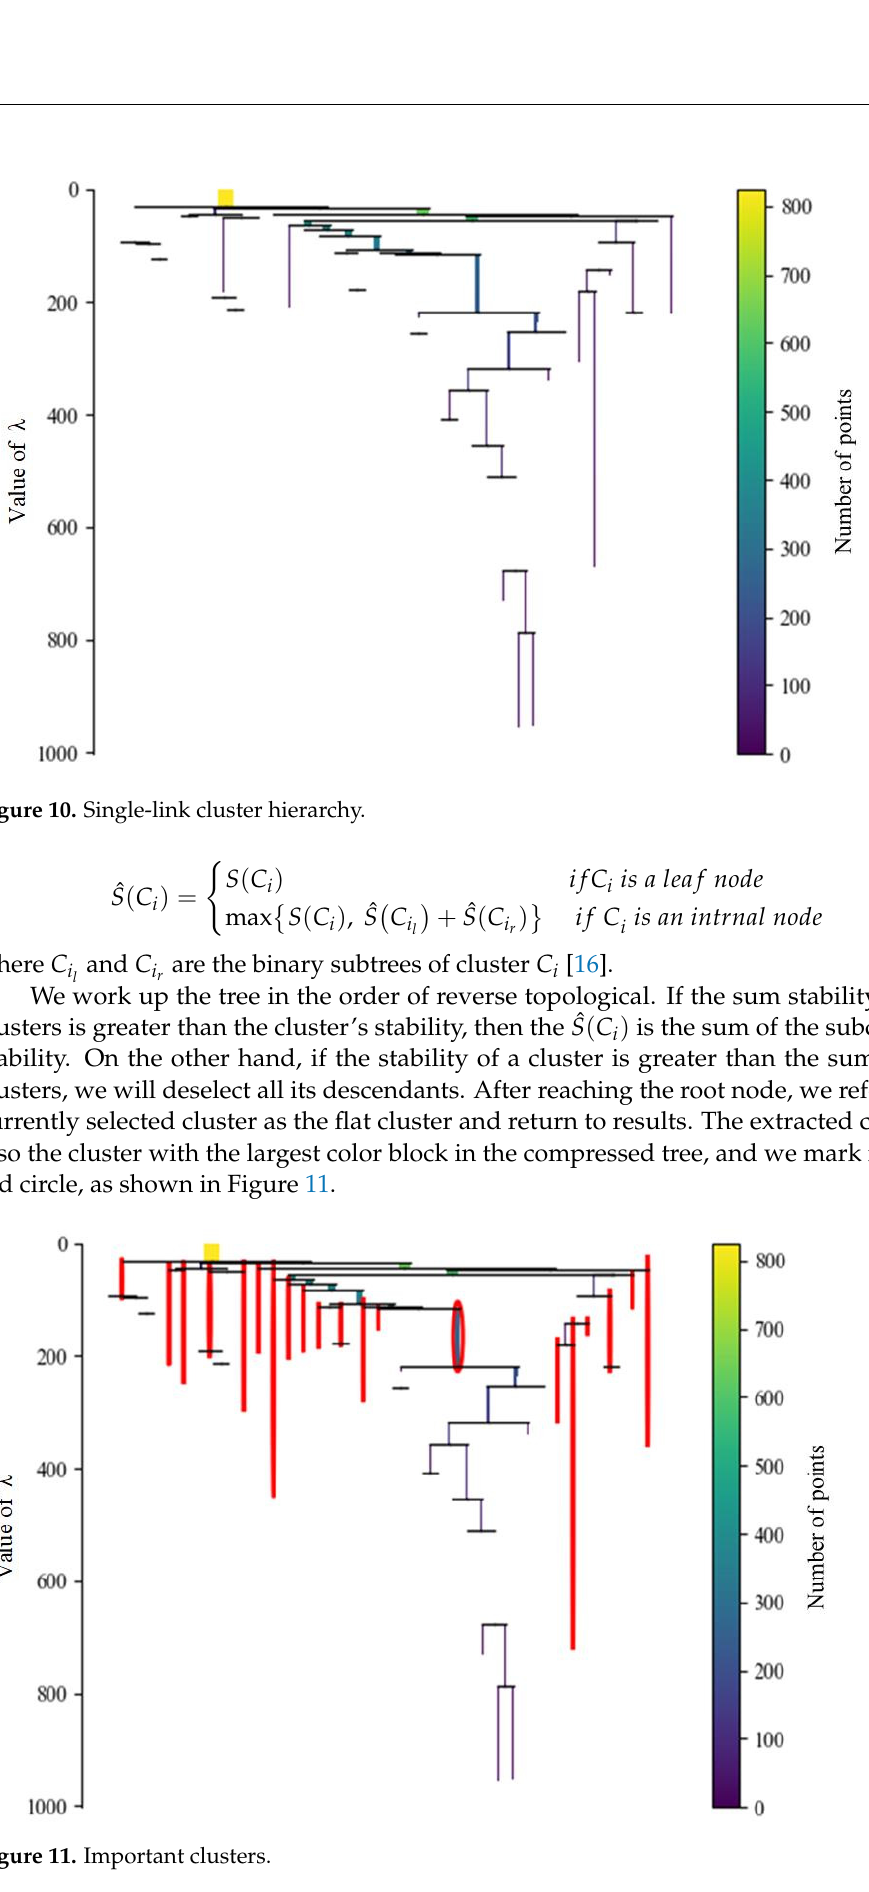
Figure 11. Important